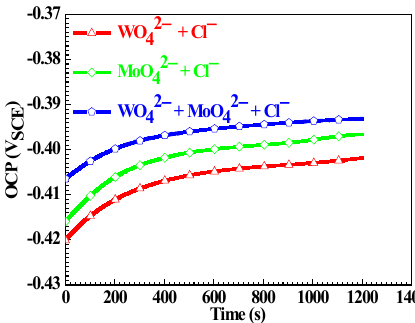
Figure 1. OCP evolutions of the Q235 samples in WO 4 2− + Cl − , MoO 4 2− + Cl − and WO 4 2− + MoO 4 2− + Cl − solutions.